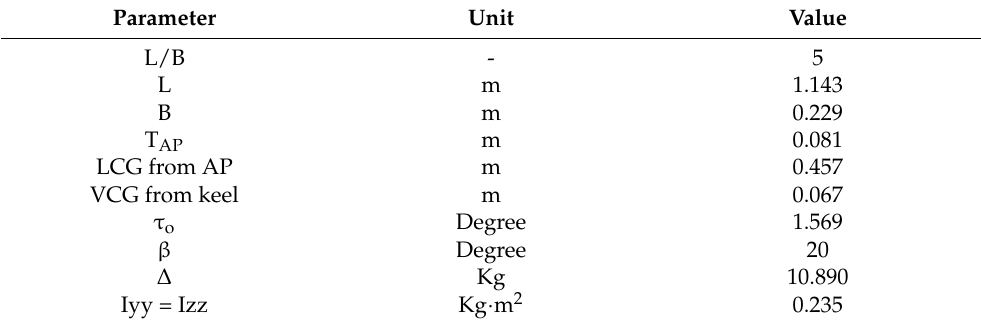
Figure 1. Fridsma hull form [7].